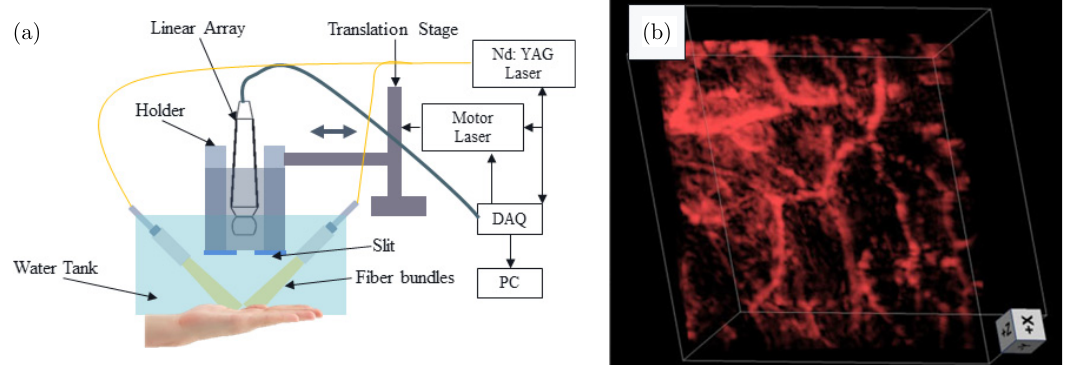
Fig. 4. Slit-based linear PAT proposed in Ref. 33. (a) Schematic drawing of the slit-based linear-array PAT system. (b) 3D palm vascular images acquired by the slit technology. This work by Y. Wang et al ., Ref. 33 is licensed under a Creative Commons Attribution 4.0 International